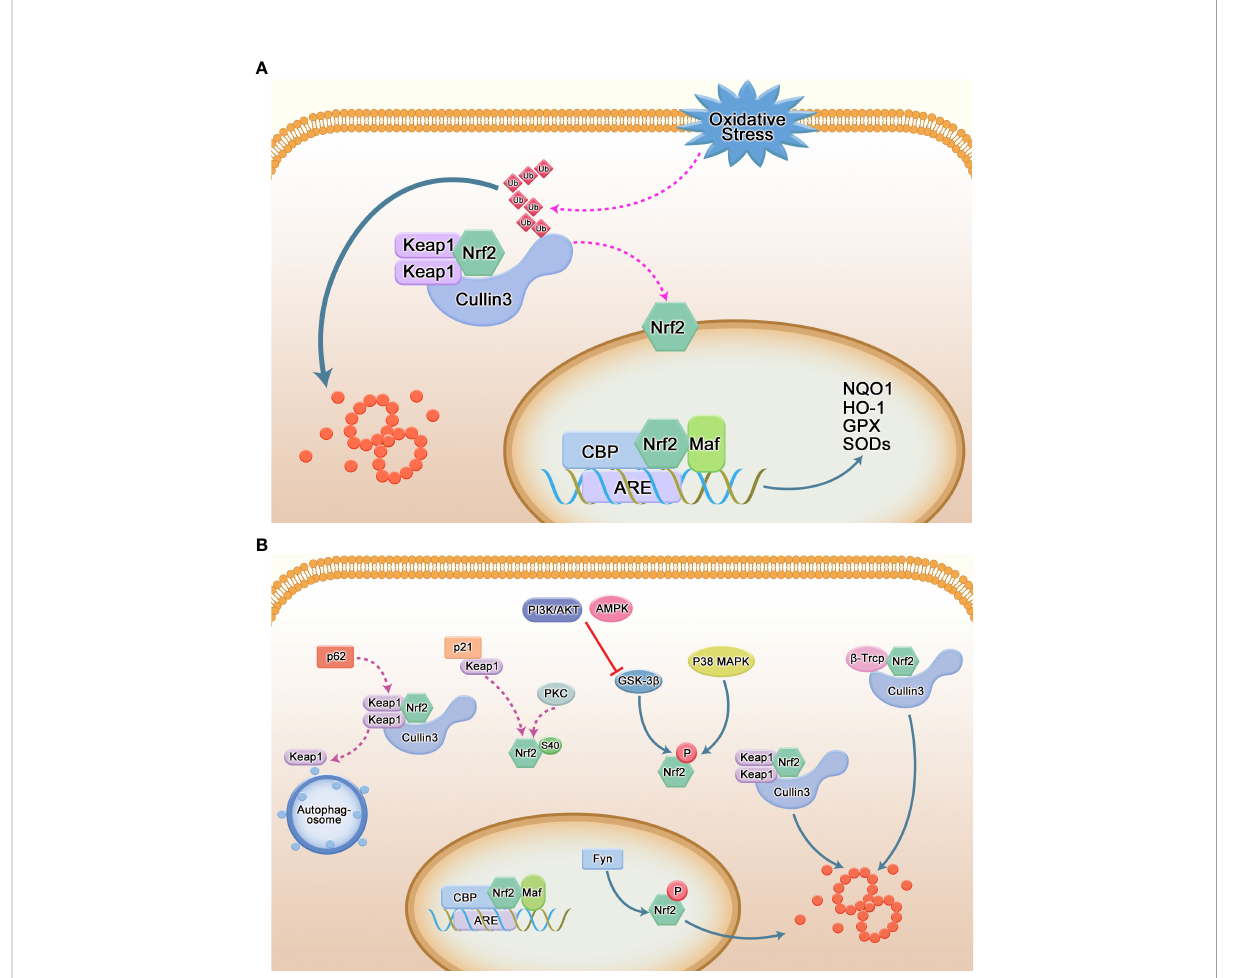
FIGURE 2 Regulation of Nrf2. (A) Canonical pathways regulated by Nrf2. Keap1 binds to Nrf2 in the form of dimers and mediates its ubiquitination degradation to maintain low levels of Nrf2 in the cytoplasm; under stress conditions, Nrf2 can dissociate from Keap1 and translocate to the nucleus to interact with AREs. After binding, the transcription of antioxidant enzymes is promoted. (B) Non-Keap1-mediated pathways. P62/ SQSTM1 is an important selective autophagy protein. After binding to Keap1, it guides it into the autophagosome, leading to the autophagic degradation of Keap1; P21 interferes with the Keap1-Nrf2 interaction by binding to Keap1 and contributes to the positive regulation of Nrf2; p38 MAPK and GSK-3 b can phosphorylate Nrf2 at Ser215, Ser408 and Ser577 and Ser334-338 of Neh6 domain, respectively, to facilitate its degradation; b -TrCP recognizes DSGIS and DSAPGS motifs to bind to Nrf2 and mediates its